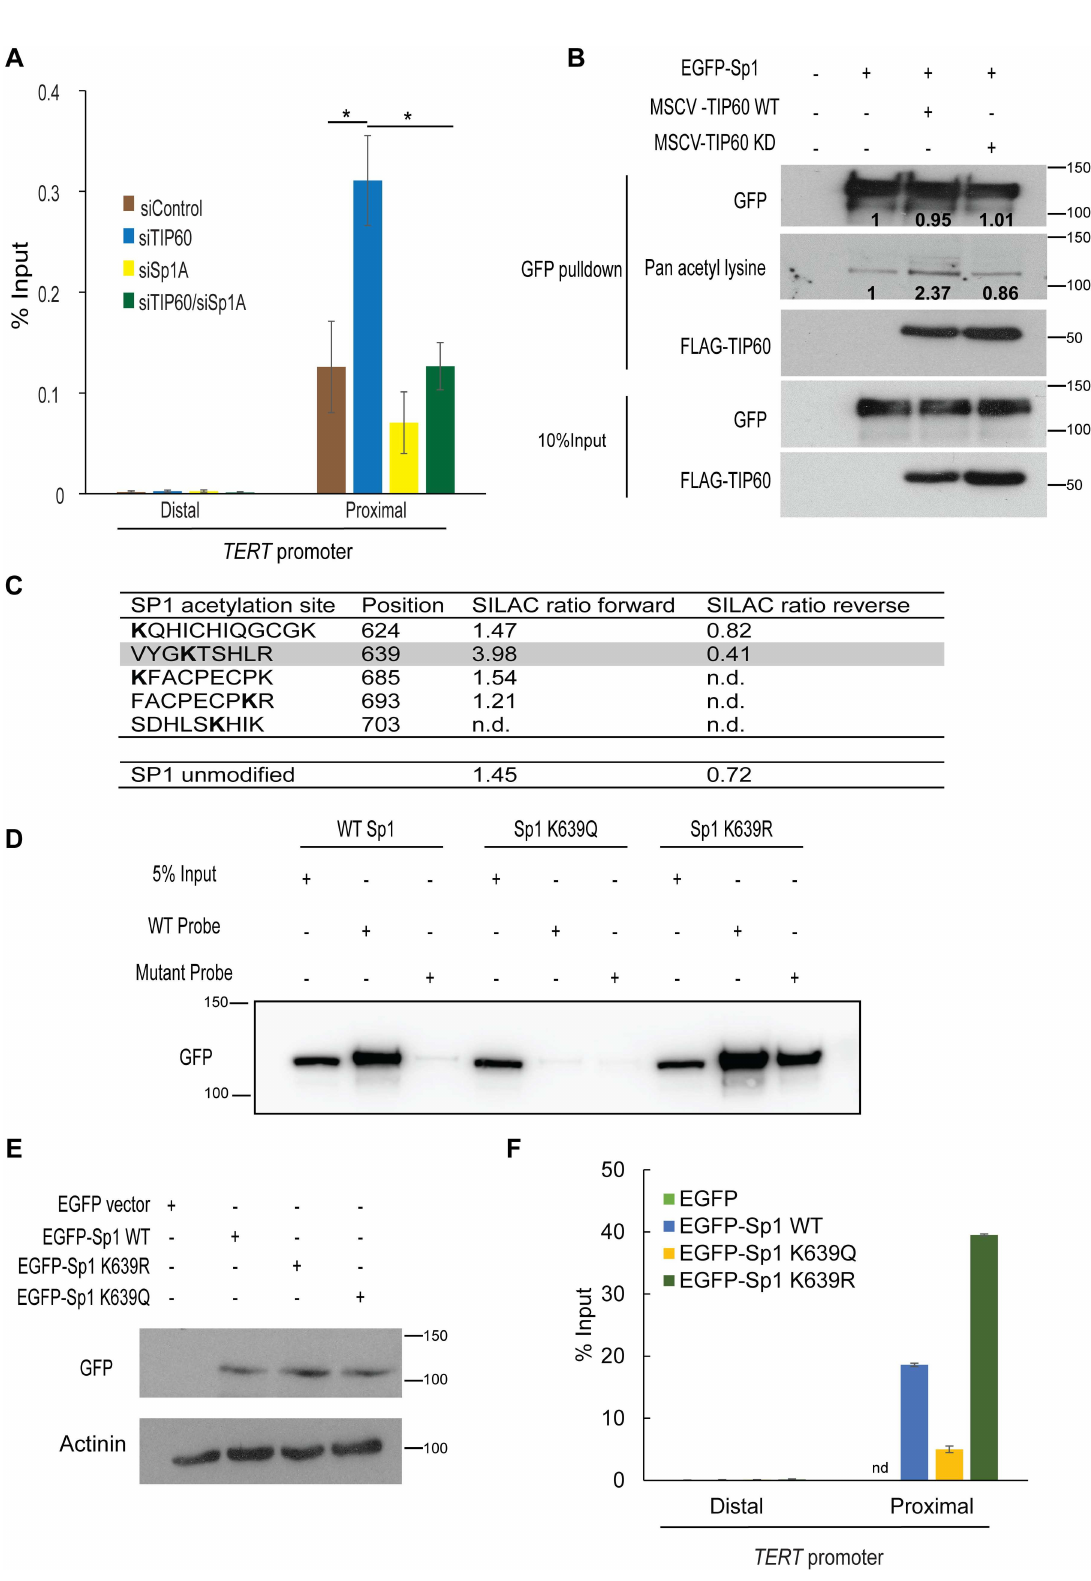
Fig 4. TIP60 acetylatesSp1 and repressesits occupancy at the TERT promoter. (A) Chromatin immunoprecipitation (ChIP) of Sp1 was performed in HeLa cells depletedof either TIP60 or Sp1 individually or together. Cells were fixed